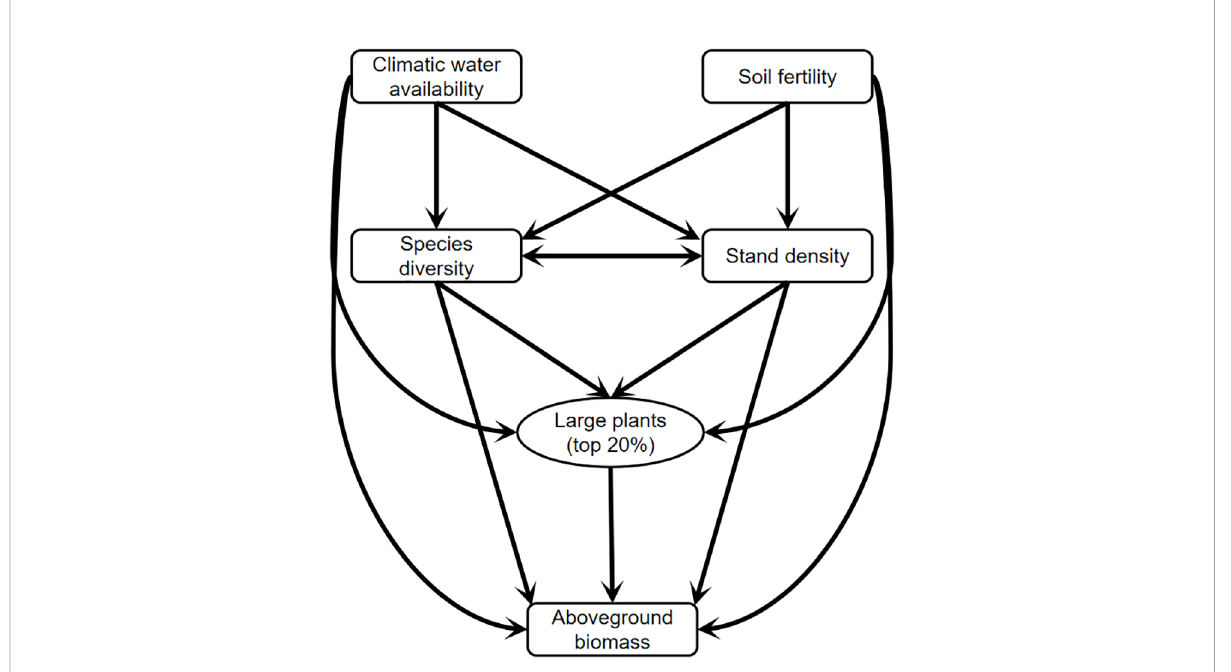
FIGURE 1 A conceptual model for testing the linkages among climatic water availability, soil fertility, large plants, species diversity, stand density, and aboveground biomass in natural forest and plantation of the arid temperate region in